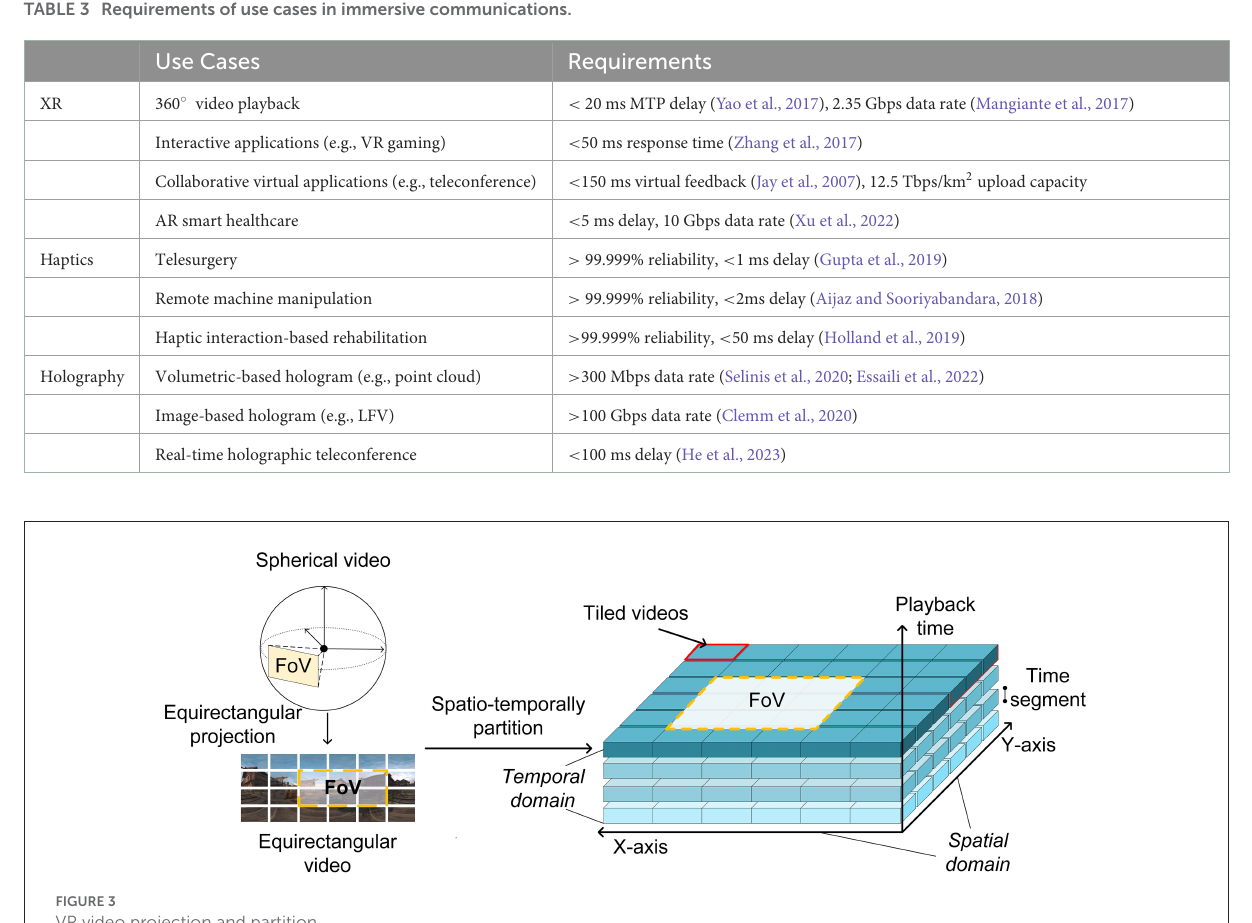
TABLE 3 Requirements of use cases in immersive communications.